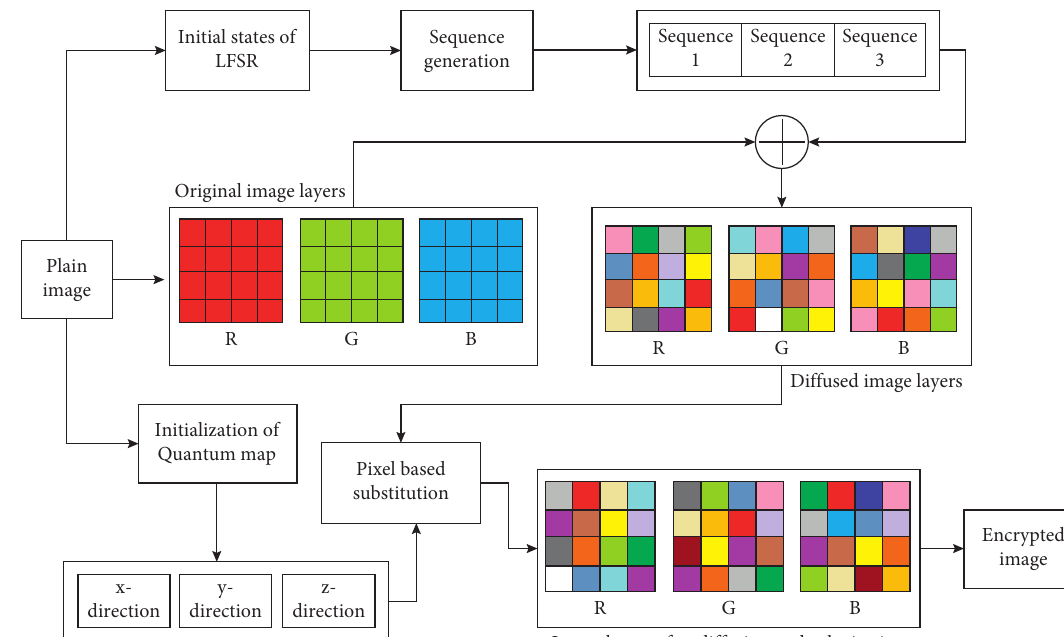
Figure 3: Design of presented encryption scheme.